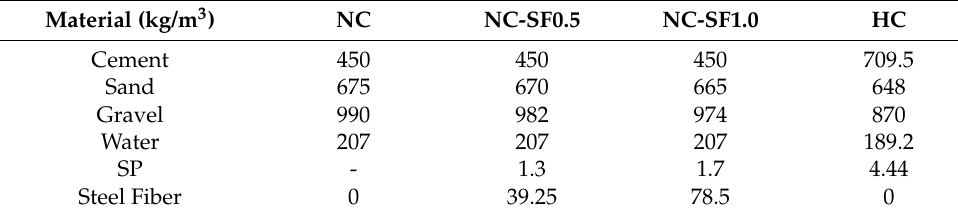
Table 1. Materials of the three mixtures (kg/m 3 ).